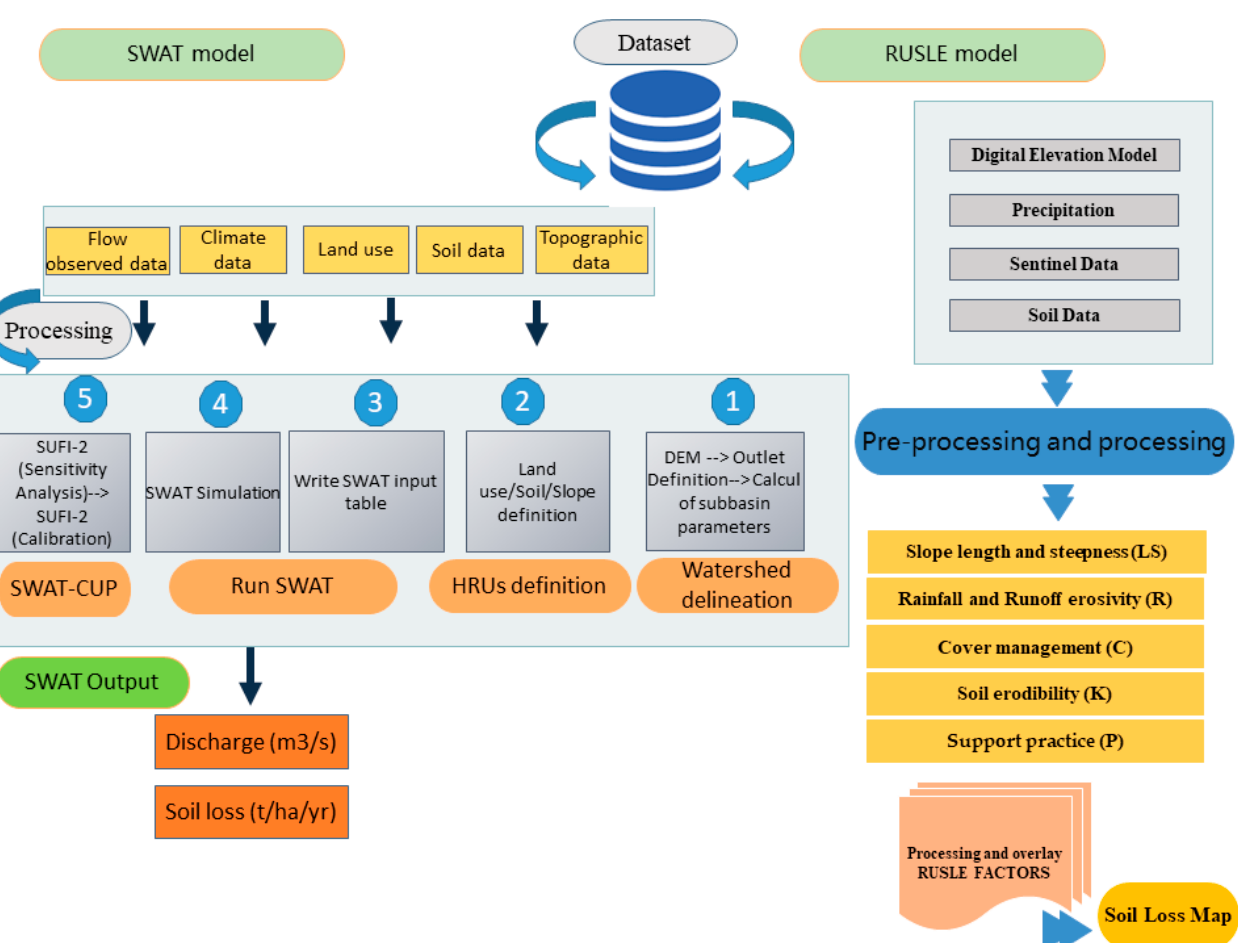
Figure 2. Methodology performed in the study.